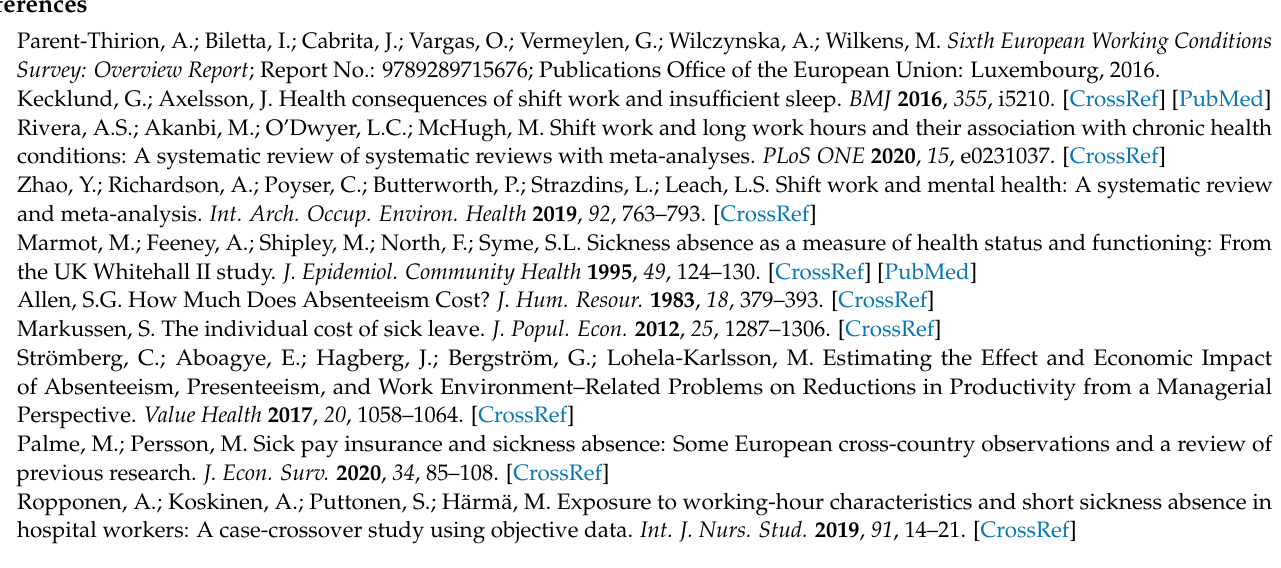
(i)—Specification estimates the average treatment effect or the treatment effects by the starting groups of the use of participatory scheduling tool; (ii)—Specification estimates the average treatment effect or the treatment effects by starting groups of the use of participatory scheduling and the shift schedule evaluation tool; —Specifications control for the age, sex, ward size, the proportion of evening and night shifts out of all shifts, and shift work characteristics including the percentages of >40-h working weeks, >48-h working weeks, >12-h shifts, long spells of work shifts, <11-h shift intervals, <28-h recovery periods after last night shift, realized shift plans, weekend work, and single free days. The estimated effect is the average treatment effect on the treated measured as days or episodes of sickness